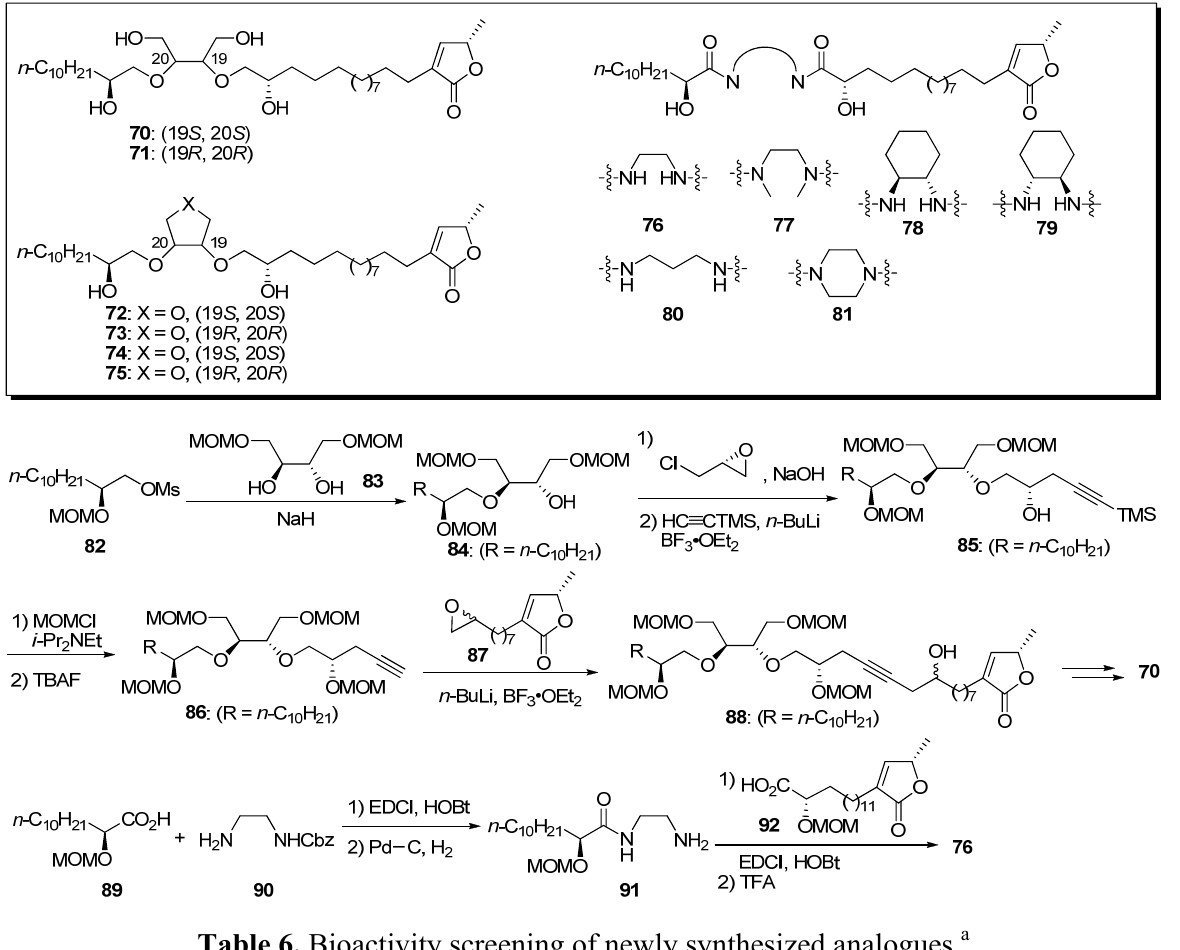
Table 6. Bioactivity screening of newly synthesized analogues.